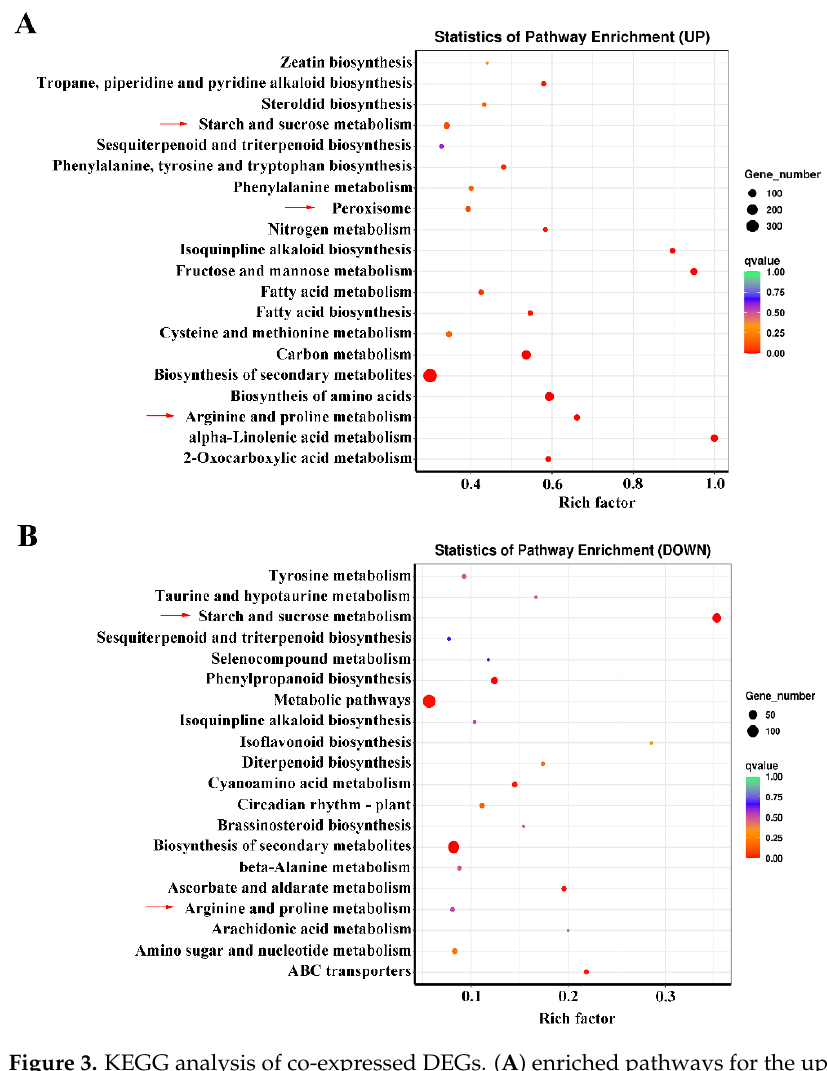
Figure 3. KEGG analysis of co-expressed DEGs. ( A ) enriched pathways for the upregulated DEGs; ( B ) enriched pathways for the downregulated DEGs.